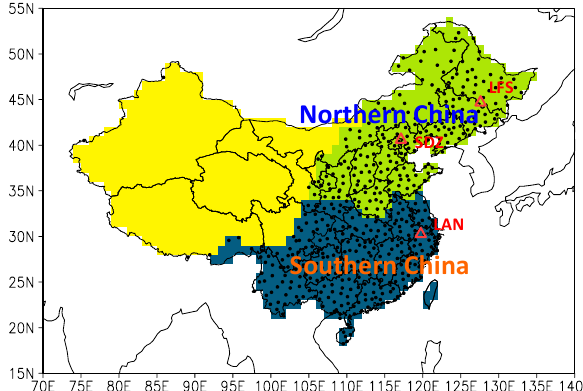
Figure 3. Locations of observations (black point: meteorological data locations; red triangle: CO 2 observation sites in China, which are used for evaluation in this